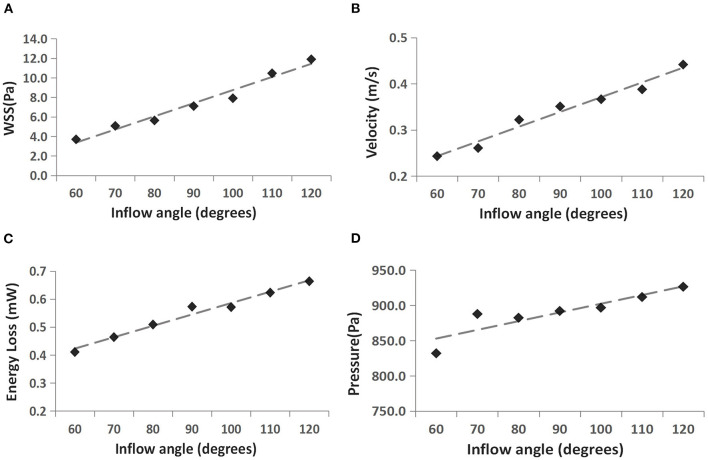
Correlation between four hemodynamic parameters and inflow angle. (A) WSS vs. inflow angle, (B) velocity vs. inflow angle, (C) EL vs. inflow angle, and (D) pressure vs. inflow angle.